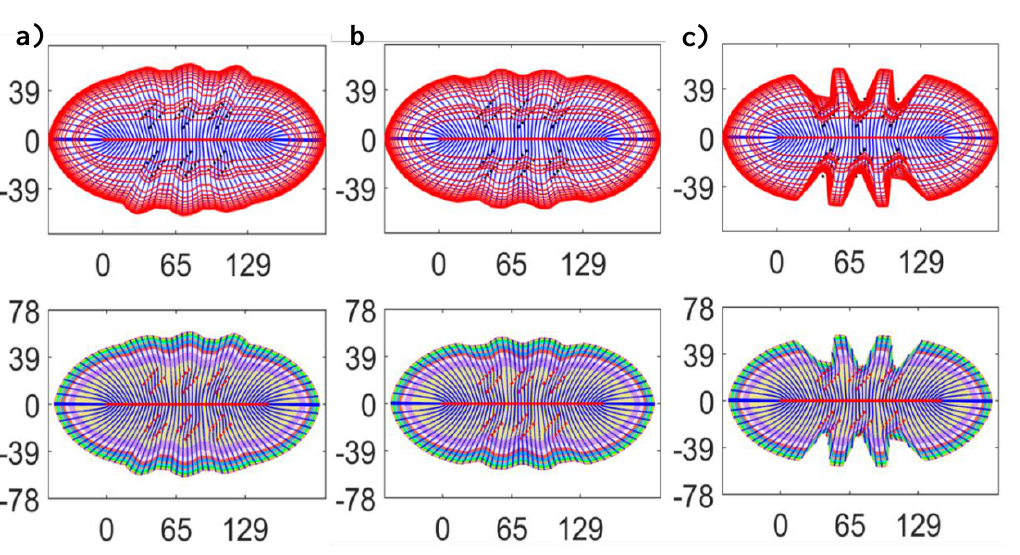
Figure 10. Hydraulic fracture model showing effect of competing changes in natural fracture (NF) porosity and permeability changes in a reservoir space of a 5% porosity. ( a ) NF porosity same as reservoir (5%) and enhanced strength of 5000 ft 4 / day ( b ) NF porosity of 10% and enhanced strength of 5000 ft 4 / day ( c ) NF porosity of 20% and enhanced strength of 5000 ft 4 / day. Streamlines in blue and TOF in red. Natural fracture zones in dashed lines.